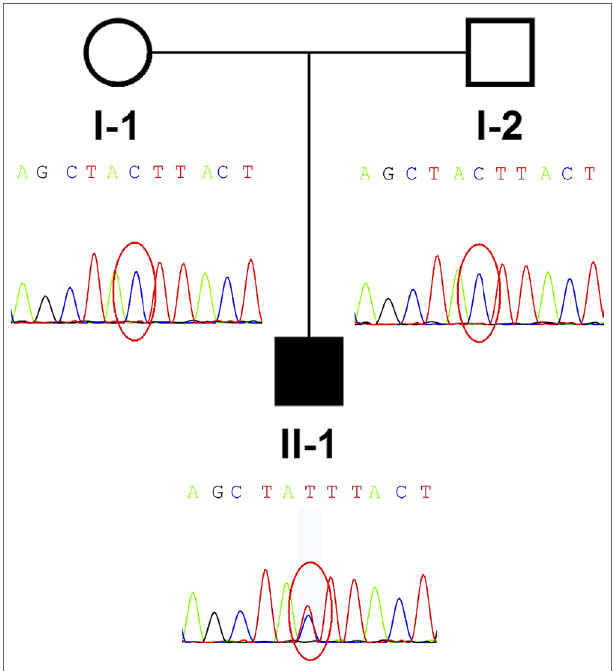
FIGURE 1 | Pedigree and de novo IGF2 variant identified in the family. The proband (II-1) was the only patient in the family and carried a de novo IGF2 variant. The parents of the patient were wild